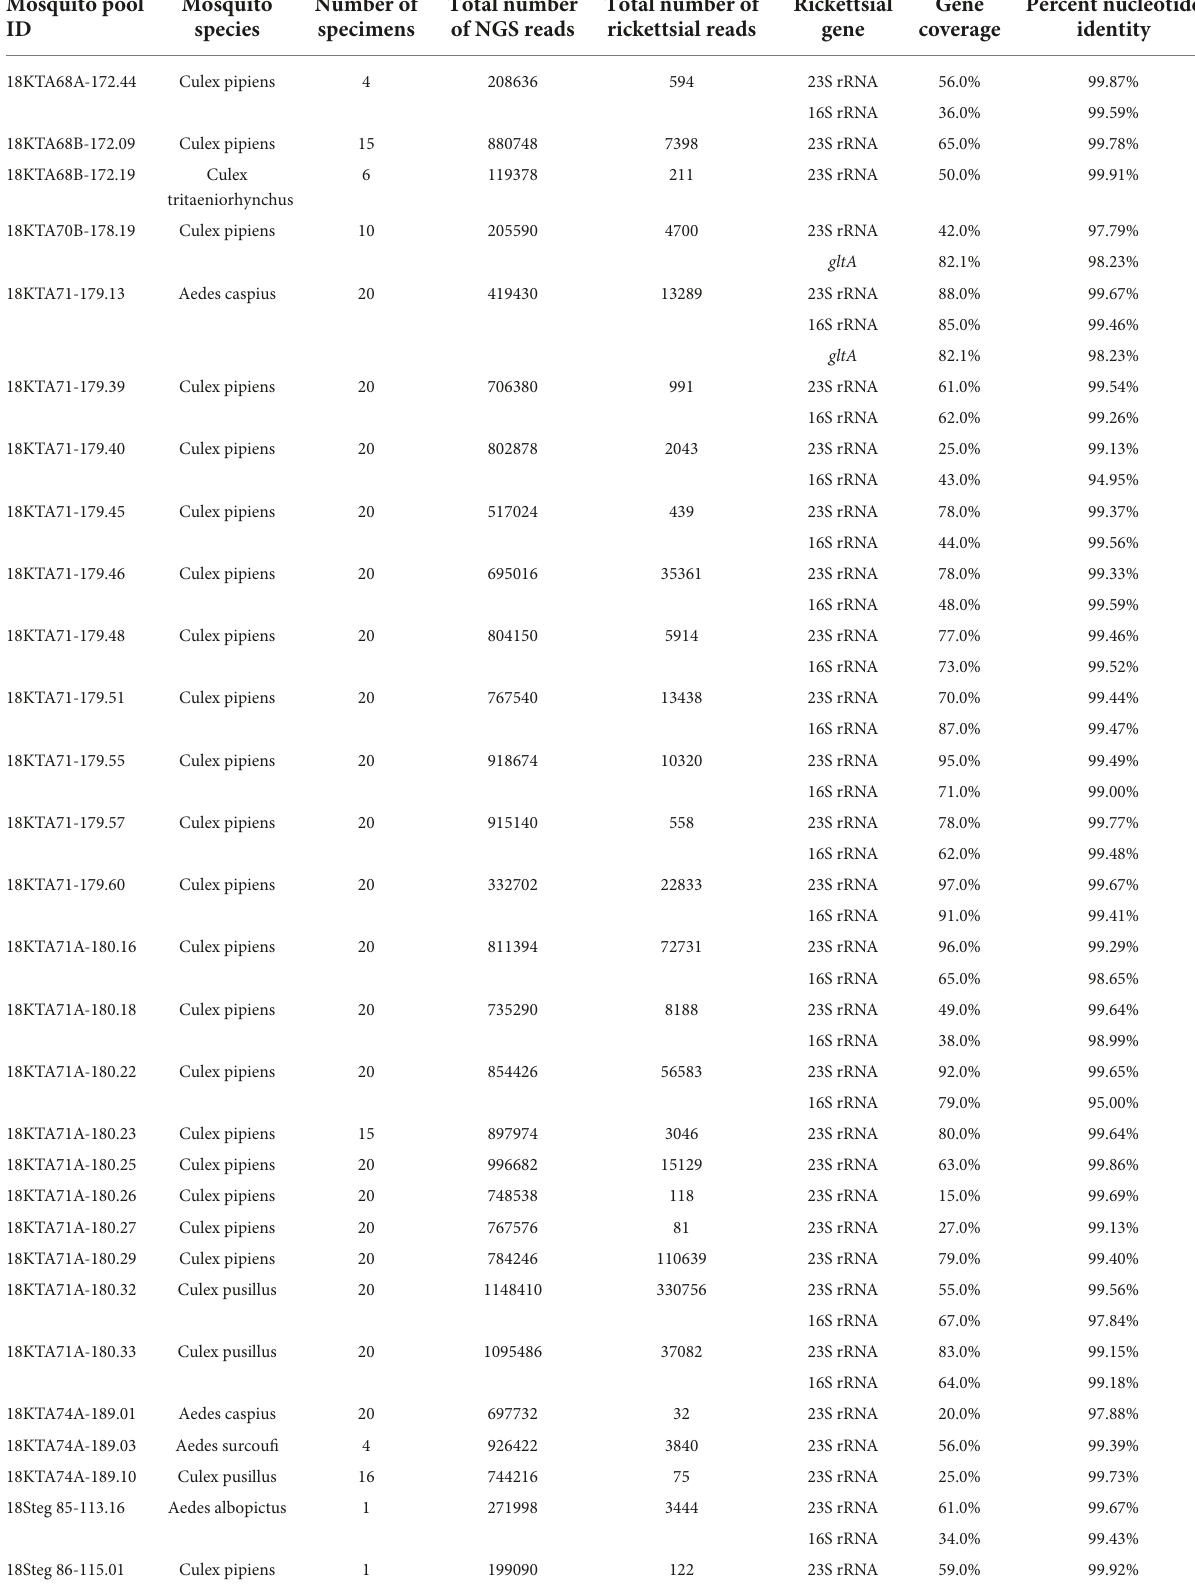
TABLE 3 Summary of metagenome next-generation sequencing and comparison of assembled rickettsial gene sequences with Rickettsia sp. MEAM1 ( Bemisia tabaci ) strain MEAM1 (GenBank accession